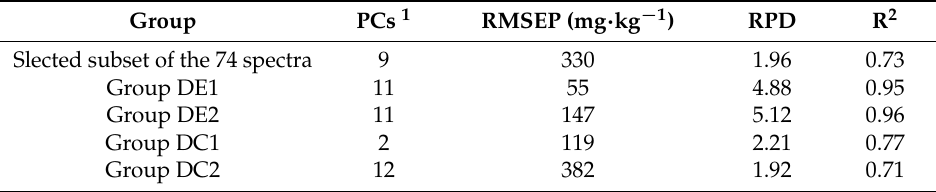
Table 4. Prediction accuracies of Zn concentrations in soil using different sets of reflectance spectra. Group PCs